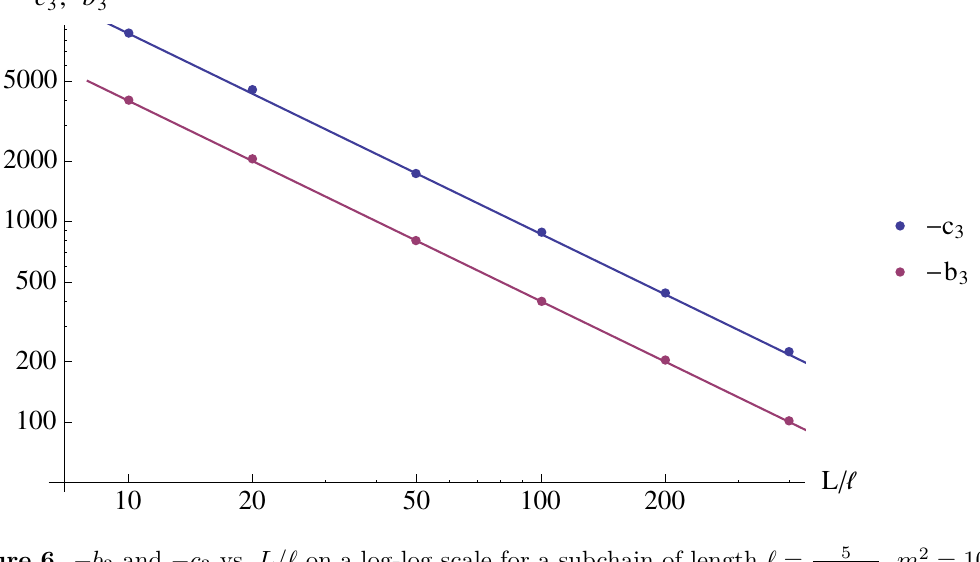
, m 2 = 10 (cid:0) 6 , p 100 10